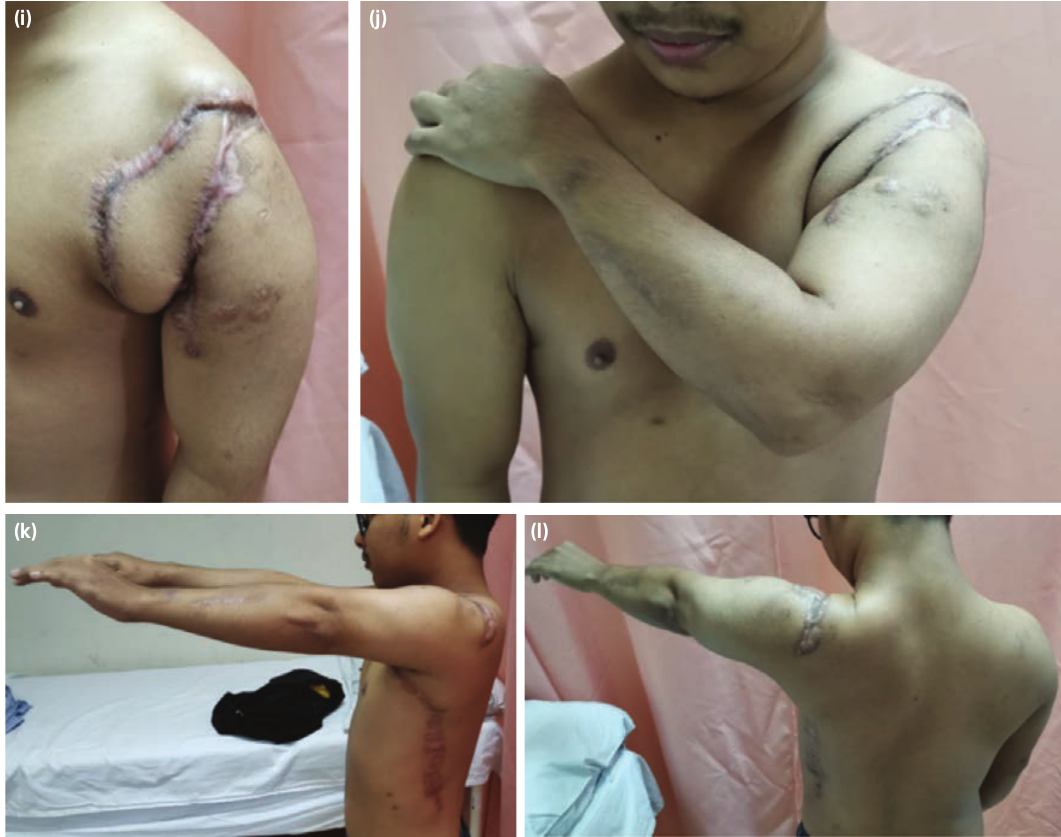
(a) Pre-operative planning of pedicled musculocutaneous latissimus dorsi flap. (b) The pre-planned pedicled musculocutaneous Fig. 3: latissimus dorsi flap was raised. (c and d) Plain radiographs (AP and lateral view) showed there was no residual sequestrum after sequestrectomy. (e and f) Final plain radiographs in AP and lateral view. After completion of antibiotics and reducing septic parameters, a second-stage procedure was carried out, involving acute shortening, Proximal Humerus Internal Locking System (PHILOS) insertion, iliac bone grafting and pedicled musculocutaneous latissimus dorsi flap. (g) The pedicled musculocutaneous latissimus dorsi flap was used to cover the soft tissue defect of the shoulder. (h) Post-operatively, the flap appeared to be healthy. (i) Two years after the second stage surgery, the patient achieved both bony union and soft tissue recovery. (j) The shoulder adduction was good. (k) The patient was able to achieve forward flexion up to 90°. (l) The patient was able to achieve abduction up to